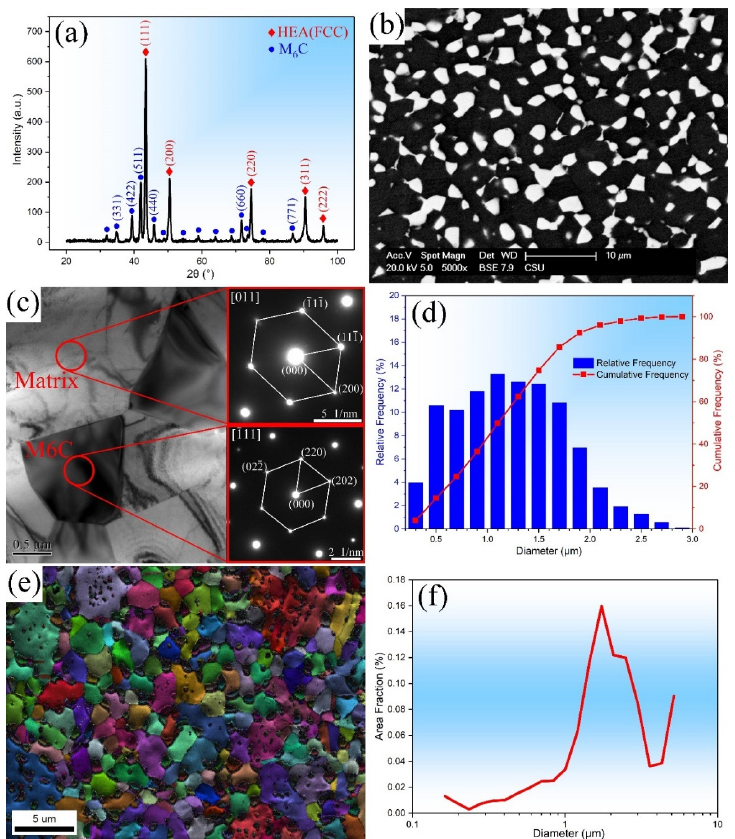
Figure 1. ( a ) XRD patterns of the high entropy alloy (HEA), ( b ) SEM micrograph of the HEA, ( c ) TEM image and selected area electron diffraction (SAED) patterns of the HEA, ( d ) size distribution of the carbide particles in the HEA, ( e ) IPF + IQ map and ( f ) grain size distribution of the HEA.